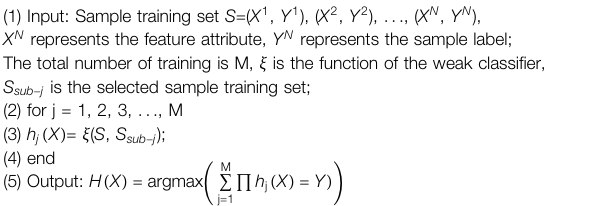
TABLE 1 | Process of the bagging classi fi cation algorithm. TABLE 2 | Fault sensors and class labels.